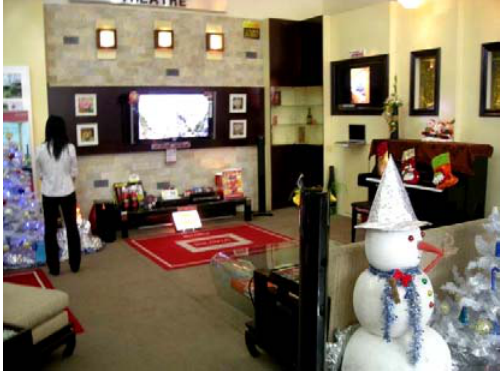
Figure 5. Display of products in a Sony